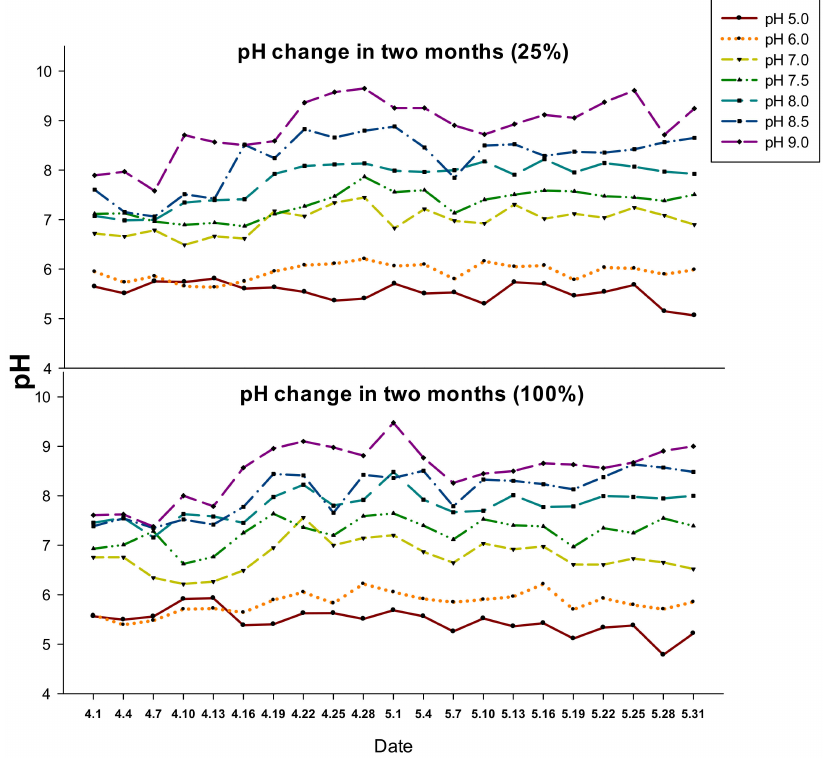
Figure 5. Changes in sand pH during the two months of treatments with 25% and 100% Hoagland’s solution with the pH levels preset at day 0 to